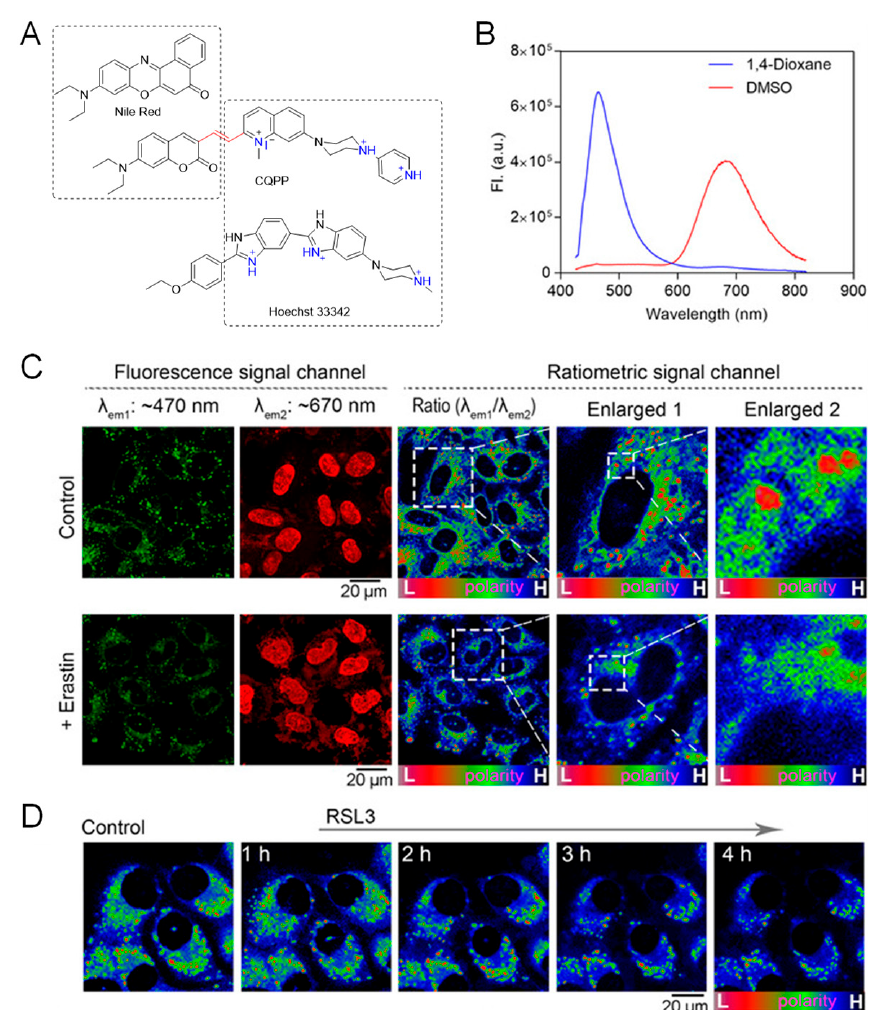
Figure 17. Polarity responsive probe CQPP and its application in ferroptosis. ( A ) Molecule design of CQPP. ( B ) Emission spectra of CQPP in 1,4 − dioxane (low polarity) and DMSO (high polarity). ( C ) Imaging of polarity changes in erastin − induced ferroptosis. ( D ) Imaging of polarity changes in RSL3 − induced ferroptosis. Reprinted/adapted with permission from Ref. [76]. Copyright 2021, Wiley − VCH GmbH.